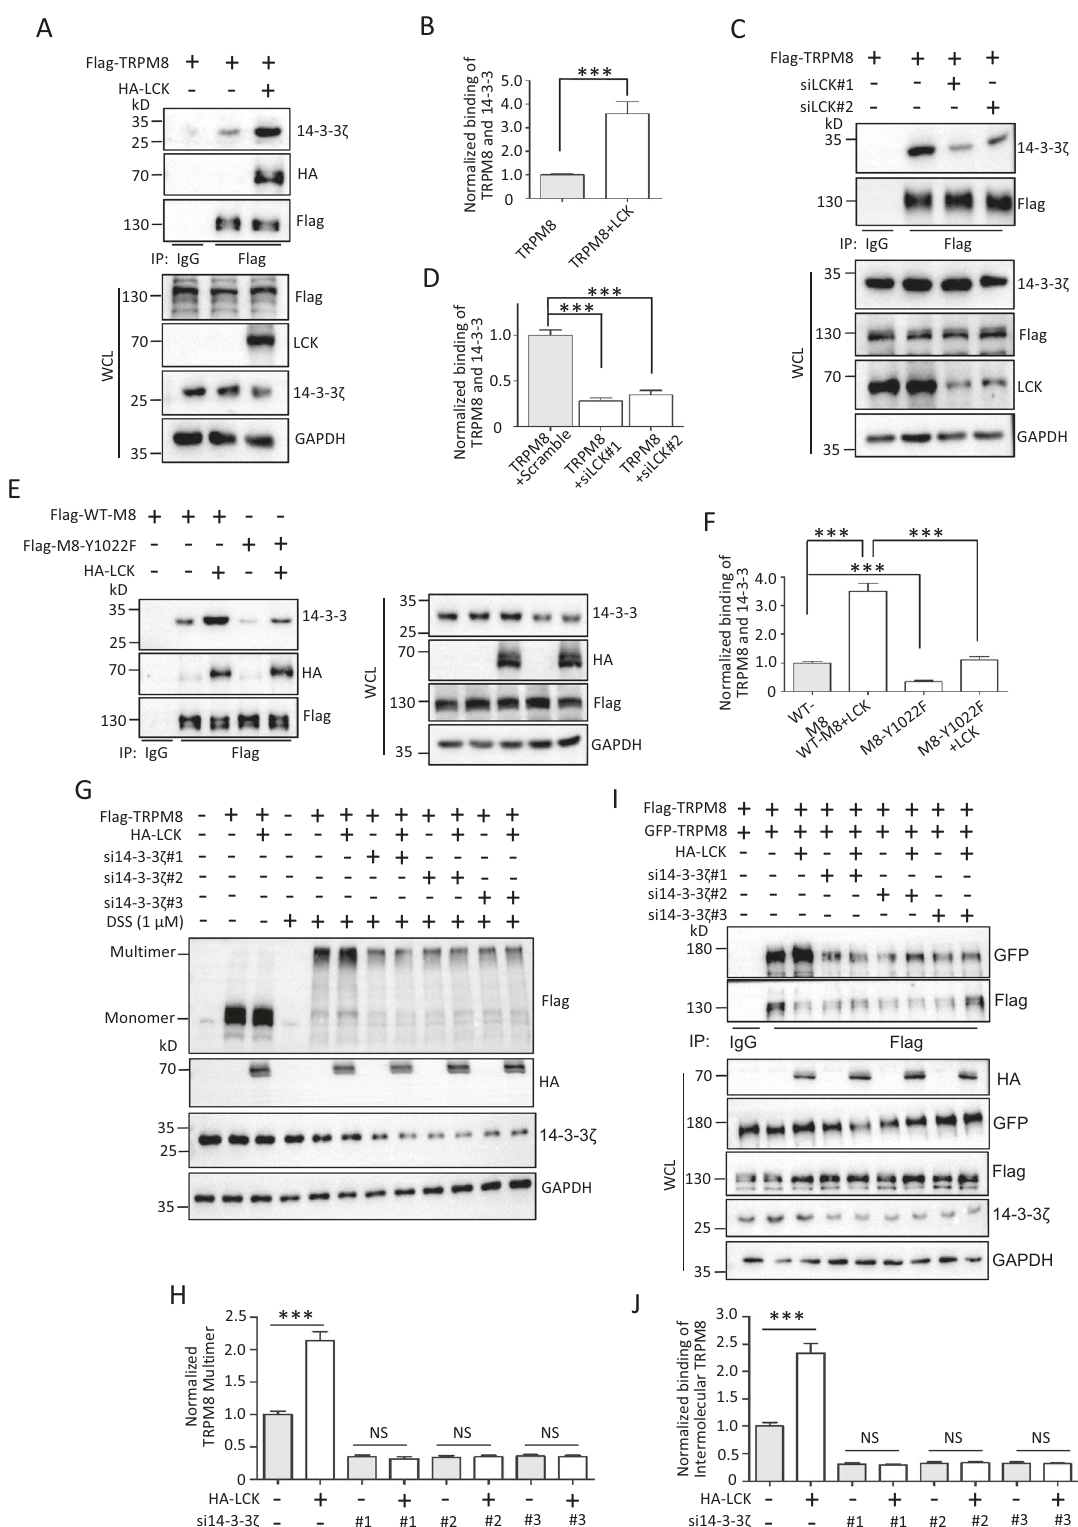
respectively (Fig. 6A – D). Meanwhile, mutant TRPM8-Y1022F signi fi cantly impaired the binding of 14-3-3 ζ and TRPM8 in the presence or absence of LCK (Fig. 6E, F). These data suggested that TRPM8 phosphotyrosine regulated by LCK positively modulated Cell Death and Disease (2022)